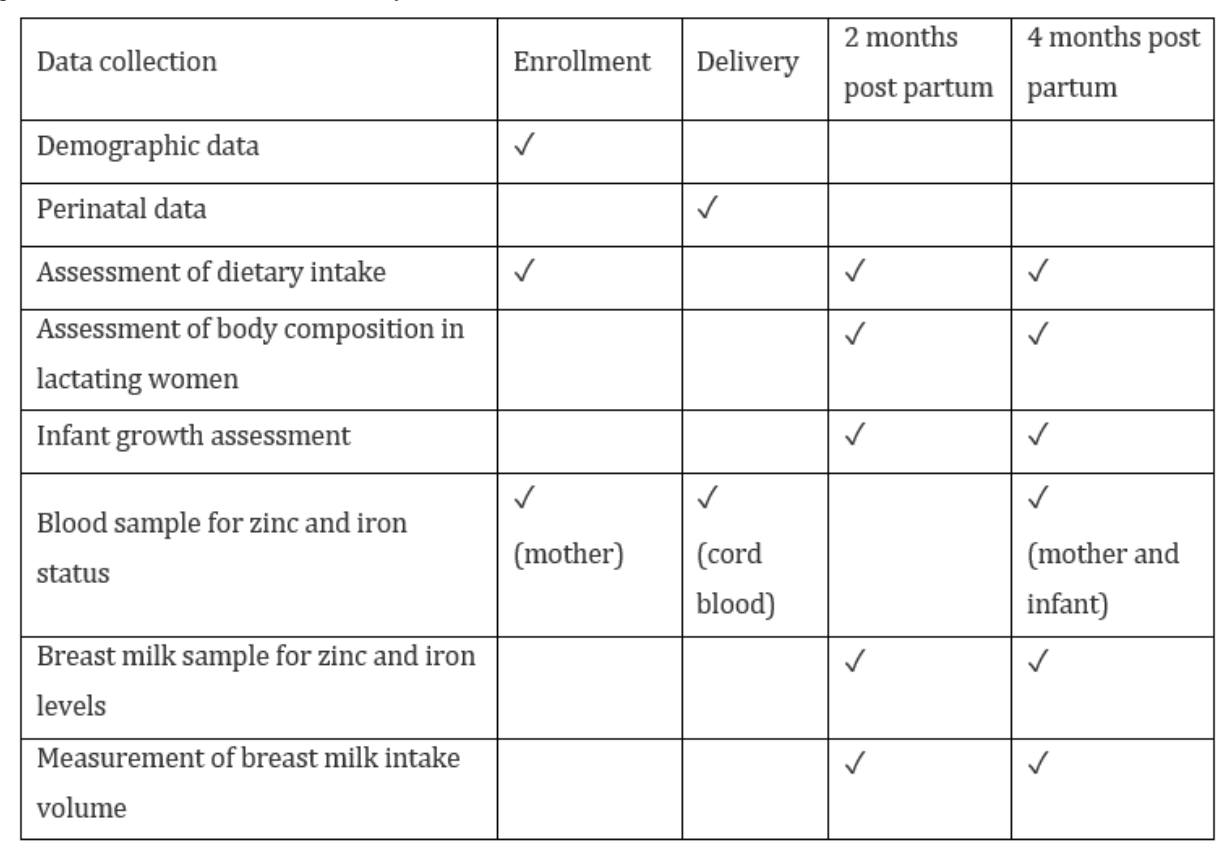
Figure 1. Data collected at each visit in the